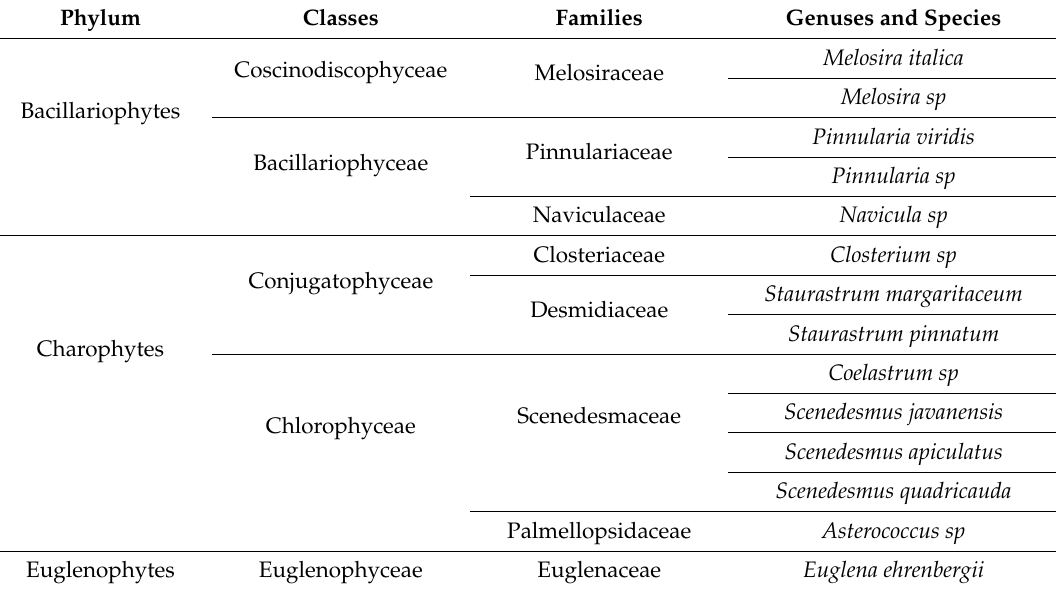
Table 2. Phytoplankton taxons identified and produced from rabbit